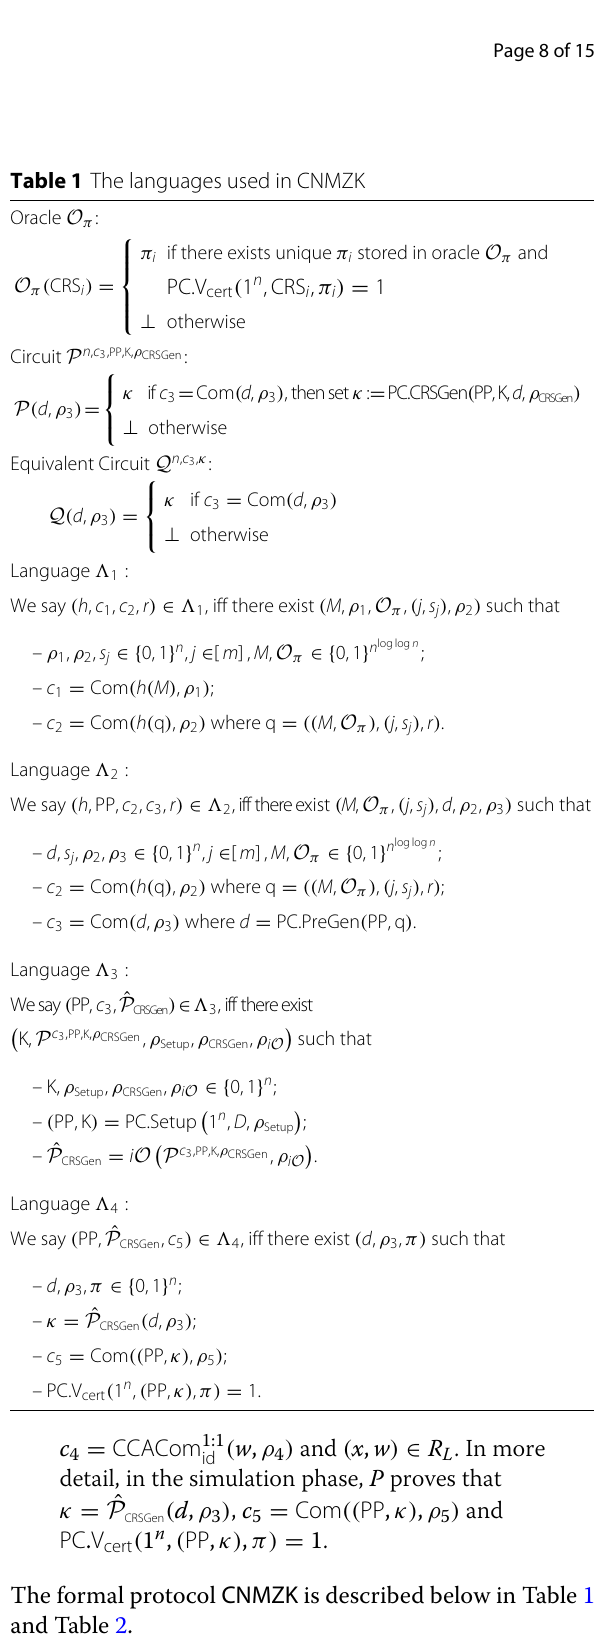
Table 1. • In stage 5, the prover P computes